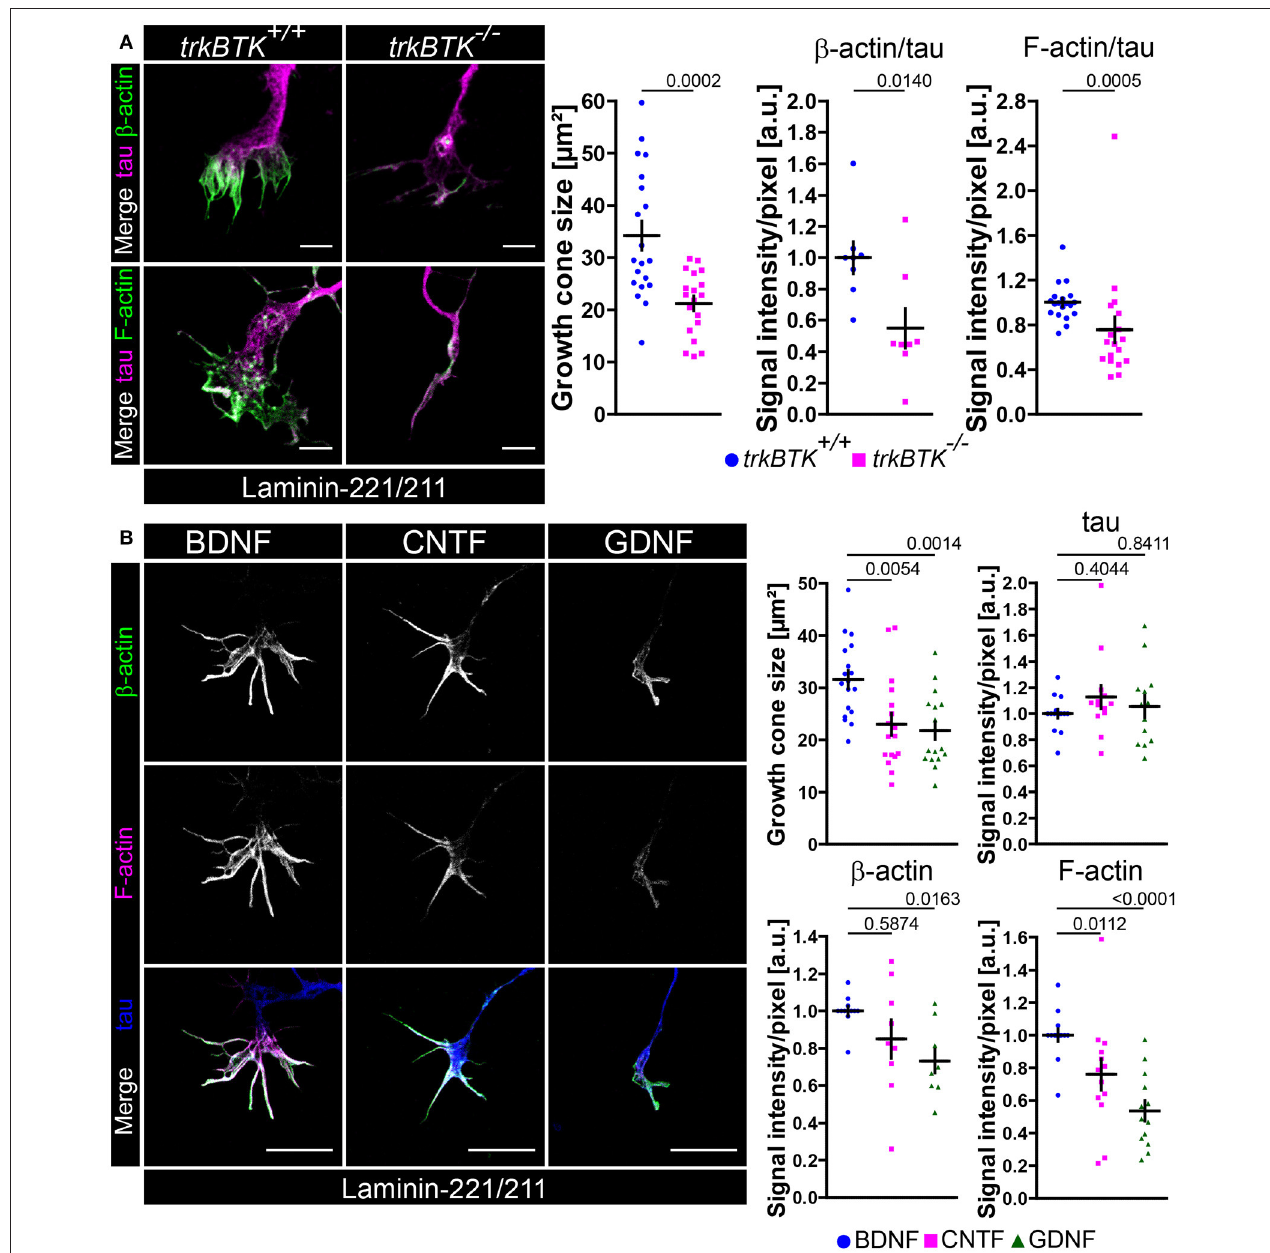
FIGURE 5 | Actin cytoskeleton deficits in growth cones of trkBTK − / − and BDNF-deprived embryonic motoneurons on laminin-221. (A) Representative images of growth cones of trkBTK + / + and trkBTK − / − motoneurons cultured on laminin-221/211 for 5 days in vitro and stained against tau (magenta) and either β -actin or F-actin (green) (scale bar: 5 µ m). TrkBTK − / − motoneurons developed significantly smaller growth cones ( trkBTK + / + 34.23 ± 2.77 µ m 2 , Q 2 29.45 µ m 2 , n = 20, N = 308; trkBTK − / − 21.22 ± 1.41 µ m 2 , Q 2 22.81 µ m 2 , n = 19, N = 341; p = 0.0002) with β -actin ( trkBTK + / + 1.00 ± 0.10, Q 2 1.00, n = 8, N = 154; trkBTK − / − 0.55 ± 0.12, Q 2 0.45, n = 8, N = 167; p = 0.0140) and F-actin ( trkBTK + / + 1.00 ± 0.04, Q 2 0.99, IQR 0.15, n = 19, N = 254; trkBTK − / − 0.76 ± 0.11, Q 2 0.64, IQR 0.44, n = 18, N = 298; p = 0.0005) deficits in comparison to wild type controls. Tau levels were comparable between both genotypes. (B) Representative images of axonal growth cones of embryonic motoneurons cultured on laminin-221/211 for 5 days in vitro in the presence of BDNF, CNTF or GDNF and stained against β -actin (green), F-actin (magenta) and tau (blue) (scale bar: 5 µ m). Growth cones of CNTF- and GDNF-treated motoneurons were significantly reduced in size (BDNF 31.59 ± 1.75 µ m 2 , Q 2 31.05 µ m 2 , n = 18, N = 385; CNTF 23.01 ± 2.12 µ m 2 , Q 2 20.73 µ m 2 , n = 17, N = 425; GDNF 21.79 ± 1.69 µ m 2 , Q 2 18.27 µ m 2 , n = 17, N = 435; p(B-C) = 0.0054, p(B-G) = 0.0014) showing F-actin deficits (BDNF 1.00 ± 0.04, Q 2 1.00, IQR 0.01, n = 14, N = 276; CNTF 0.76 ± 0.10, Q 2 0.79, IQR 0.33, n = 13, N = 308; GDNF 0.54 ± 0.06, Q 2 0.49, IQR 0.37, n = 13, N = 314; p(B-C) = 0.0112, p(B-G) < 0.0001). GDNF-treated growth cones revealed a reduction in β -actin levels. Tau was comparable in each analyzed